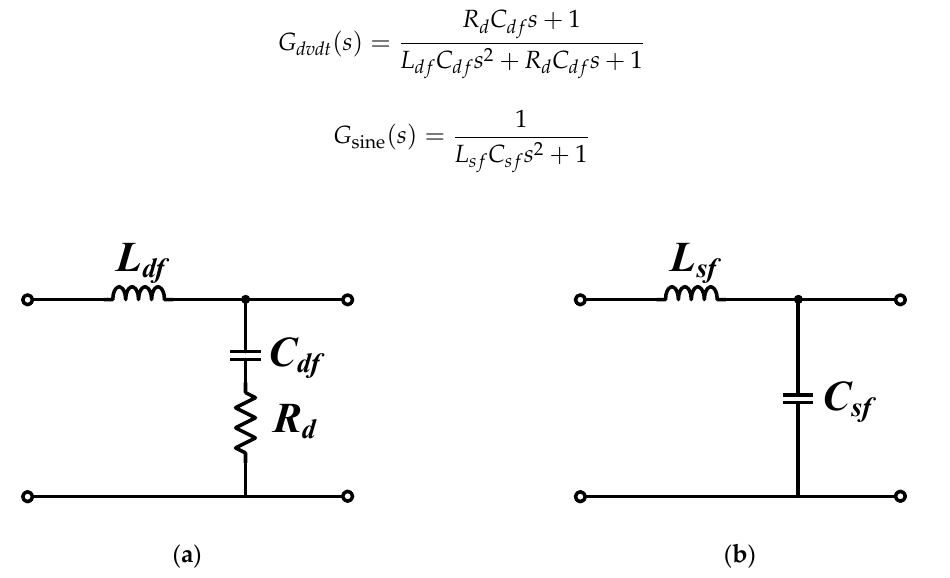
Figure 5. Output filter circuit; ( a ) for dv / dt filter; ( b ) for sine-wave filter. Table 1. National electrical manufacturers association (NEMA) dv / dt standards.